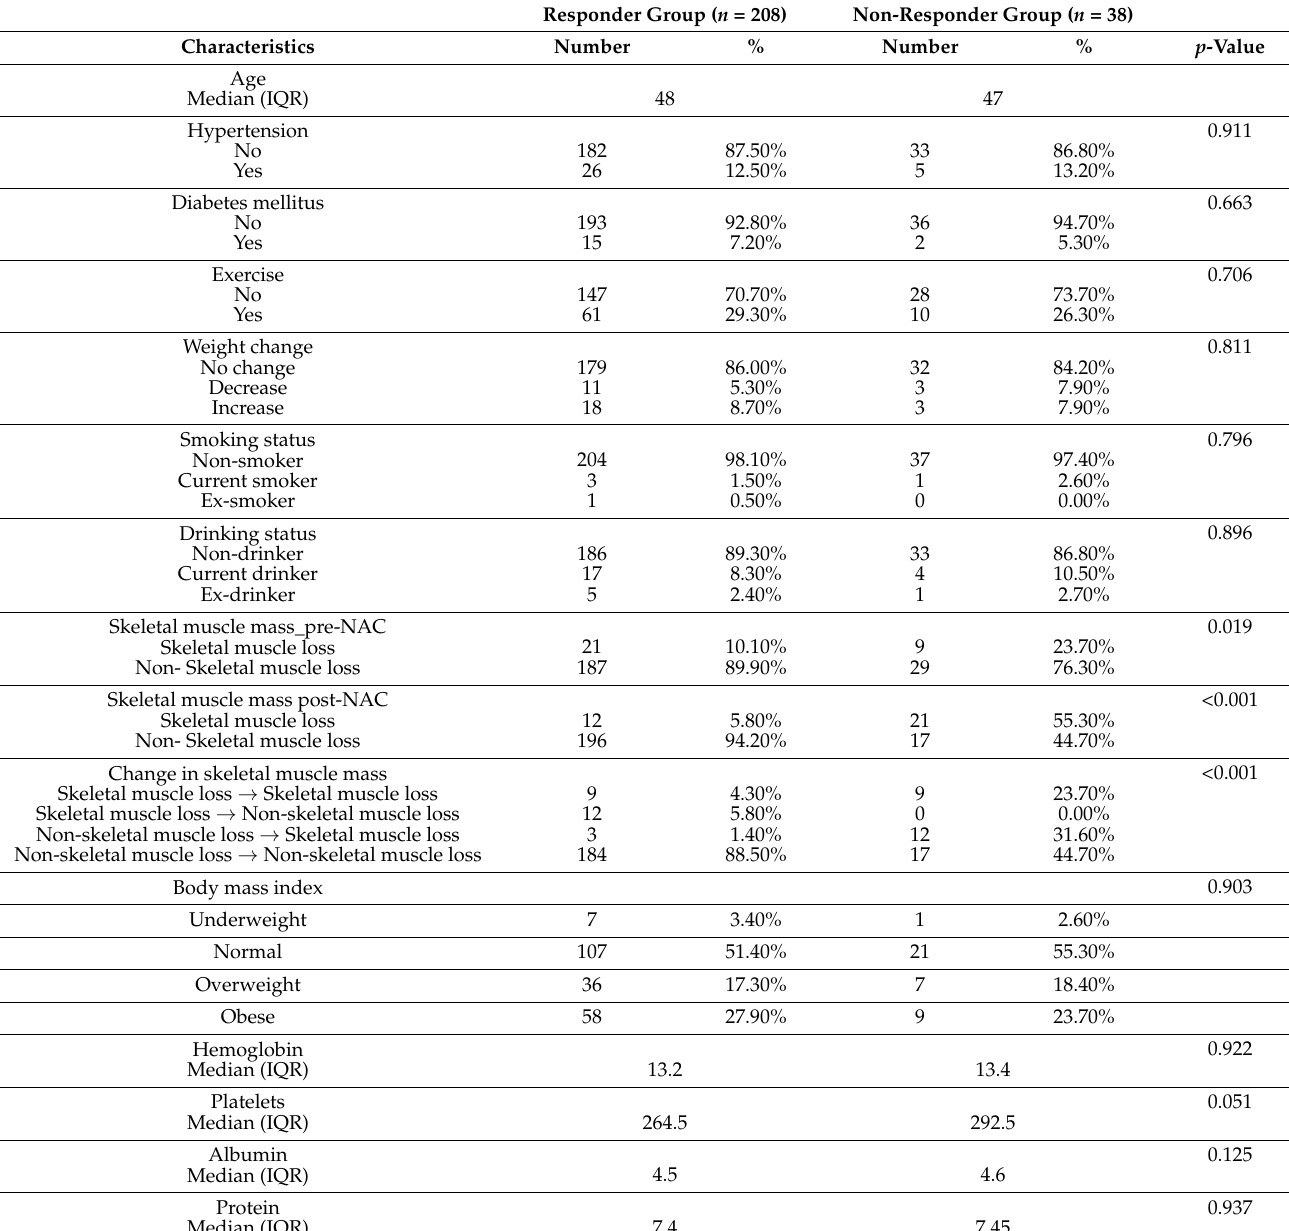
Table 3. Comparison of patient characteristics according to the response to NAC.